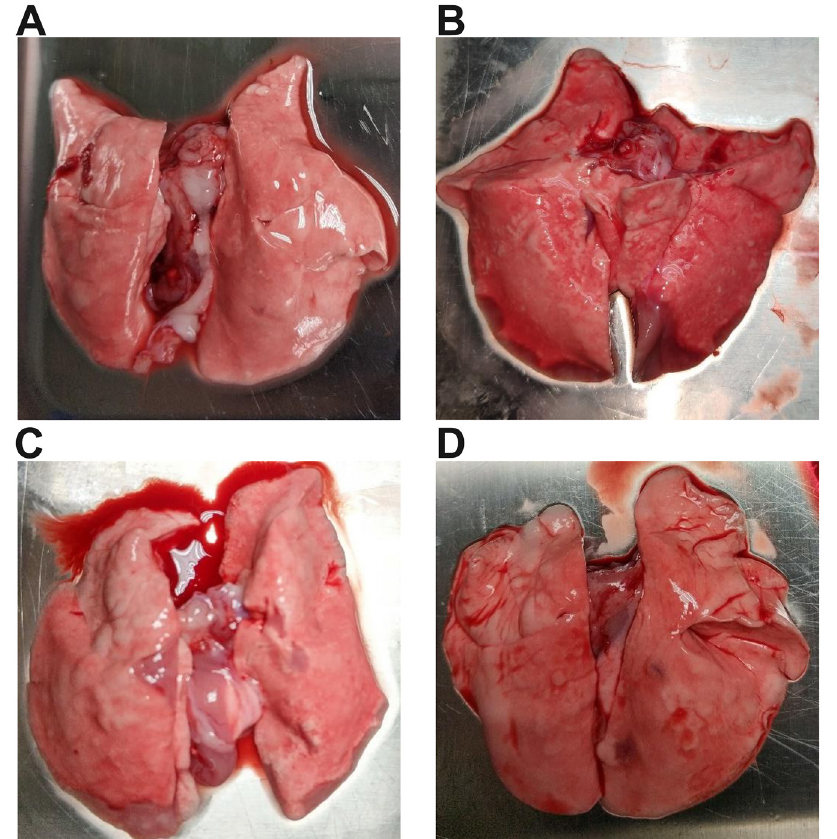
FIGURE 2 - General observation for lungs in different groups (A: Montmorillonitec control group; B: PQ poisoning group; C: Immediate treatment group; D: Delayed treatment